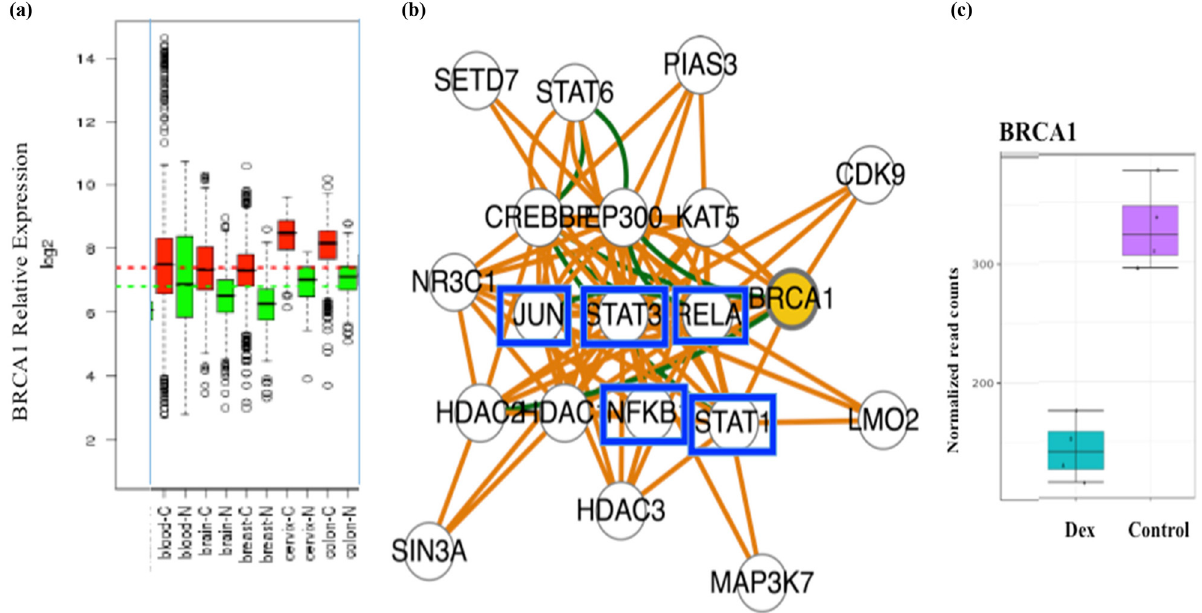
Figure 5: Relative mRNA expression levels of BRCA1 in normal and cancer tissues and BRCA1 as a novel/critical node for RELA and STAT3 hubs. ( a ) Box plots in selected tissues include blood, brain, breast, cervix, and colon. Cancer ( C ) and Normal ( N ) tissues are indicated by Red and Green, respectively. ( b ) Network analysis of common interaction partners of RELA and STAT3 signaling hubs. Critical node ( BRCA1 ) is highlighted in yellow color, components of the module are indicated by blue boxes, and genetic interactions by green lines. ( c ) Downregulation of BRCA1 mRNA expression by DEX in airway smooth muscle cells. Data from eight human donors re retrieved from LCTE. Control and Dex refer to cells untreated or treated with